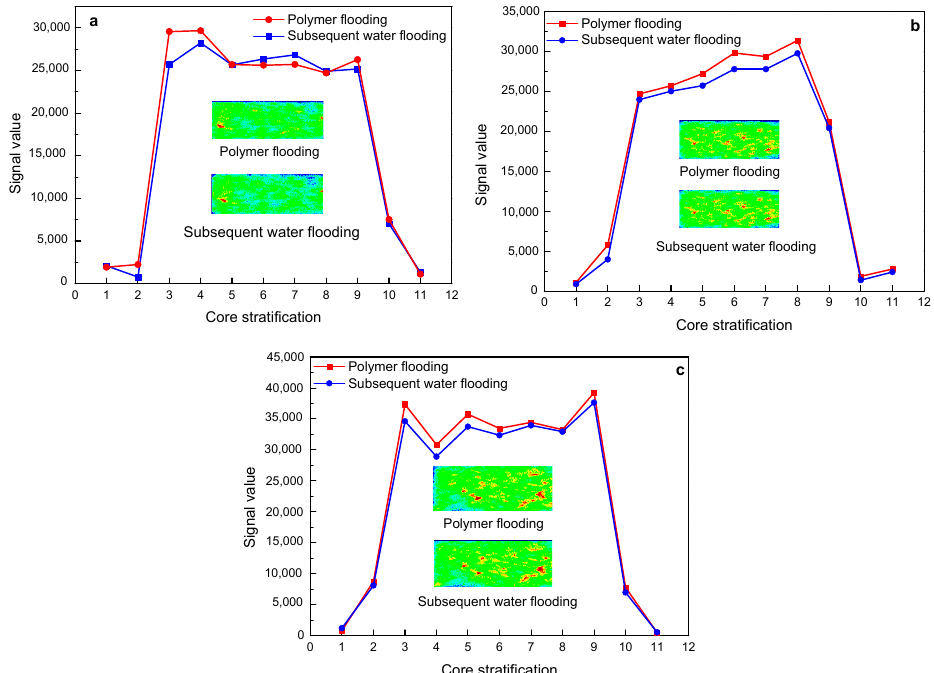
Figure 12. The change characteristics of NMR layering signal and imaging of 16 million molecular weight polymer solutions in rock cores with different permeability after polymer flooding and subsequent water flooding: ( a ) 500 mD core; ( b ) 1000 mD core; ( c ) 2000 mD core.